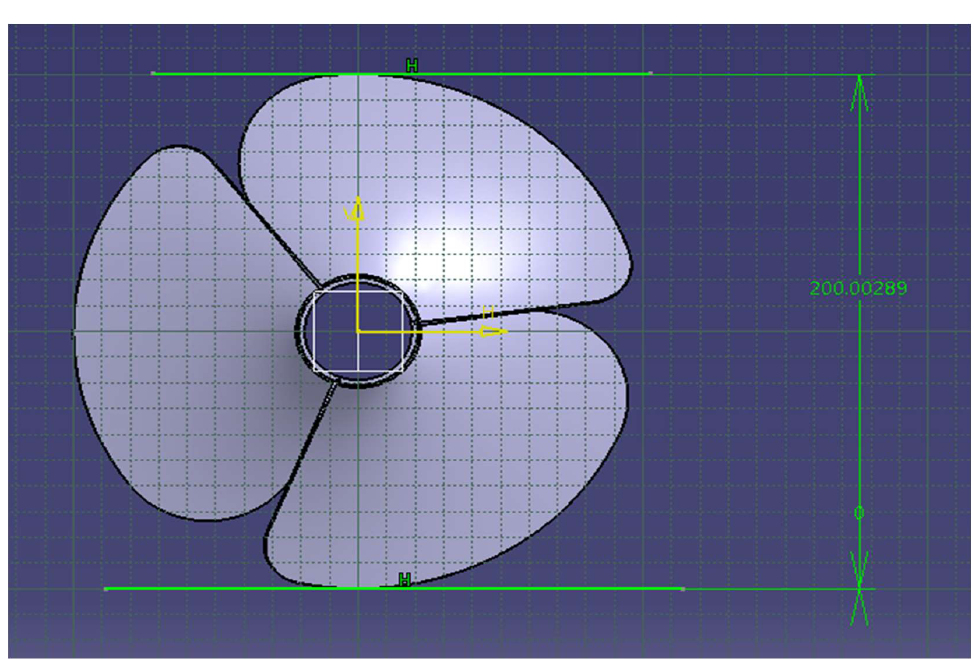
Figure 6. A distinctive front view of the imposed hydro propeller.